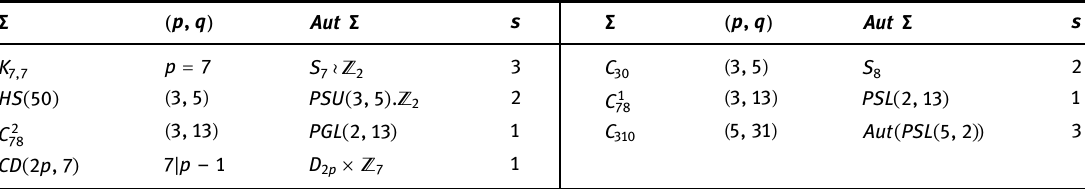
Table 1: Basic normal quotient graphs of symmetric graphs with order pq 2